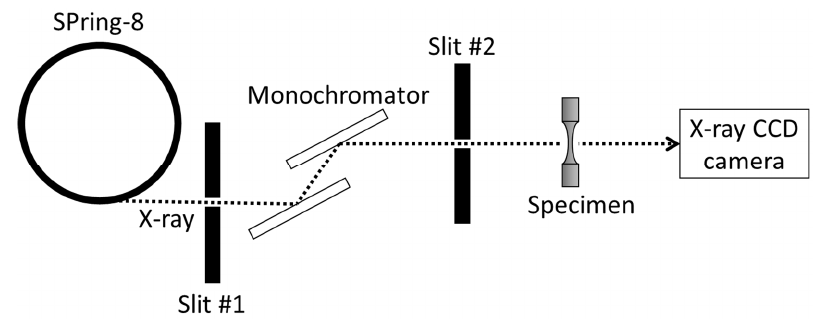
Figure 3. Set-up of the synchrotron radiation μ CT imaging.